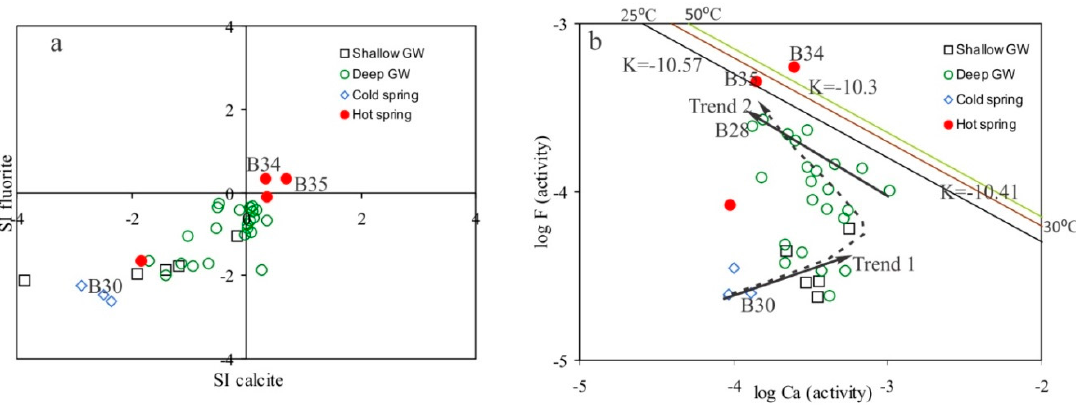
Figure 10. ( a ) Plot of Ca 2+ vs. F − , ( b ) saturation index of calcite versus saturation index of fluorite and ( c ) the relationship between the log activities of Ca and log activities of F − .